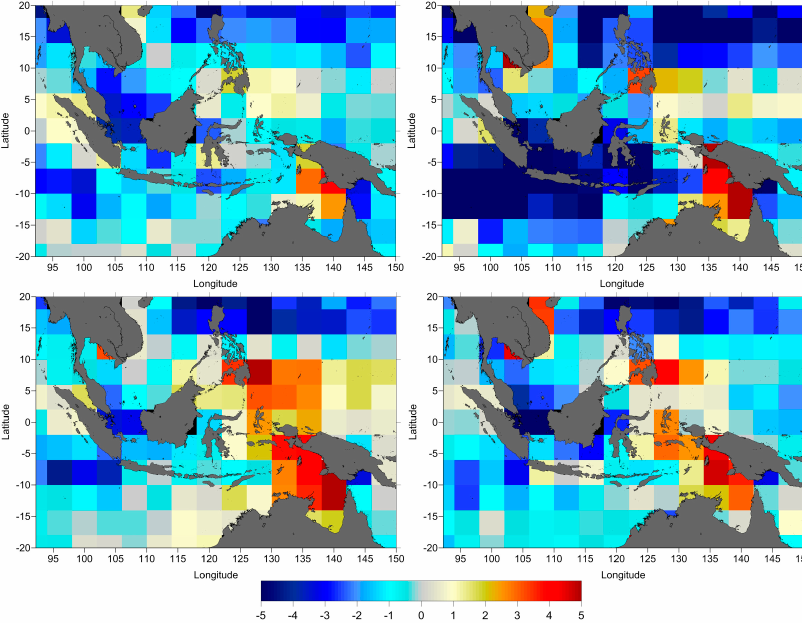
Figure 8. Along-track SLA variance differences (cm 2 ), between the smoothed dual-frequency and NIC2009 for TOPEX/Poseidon cycles 1–219 ( top left ) and between the smoothed dual-frequency and JPL GIM for TOPEX/Poseidon cycles 220 to 364 ( top right ); Jason-1 cycles 1 to 259 ( bottom left ) and Jason-2 cycles 1 to 280 ( bottom right ).